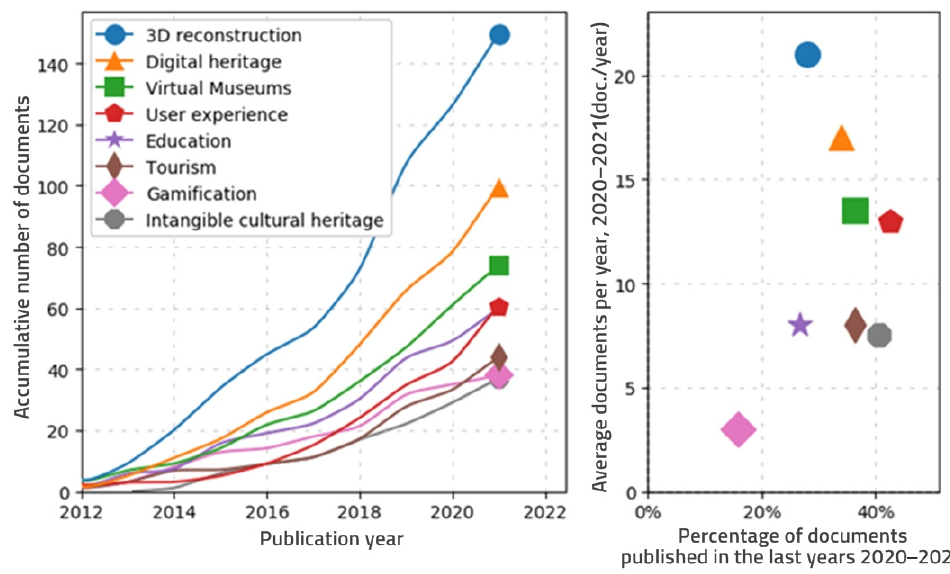
Figure 3. Top trending topics generated from the author keywords.